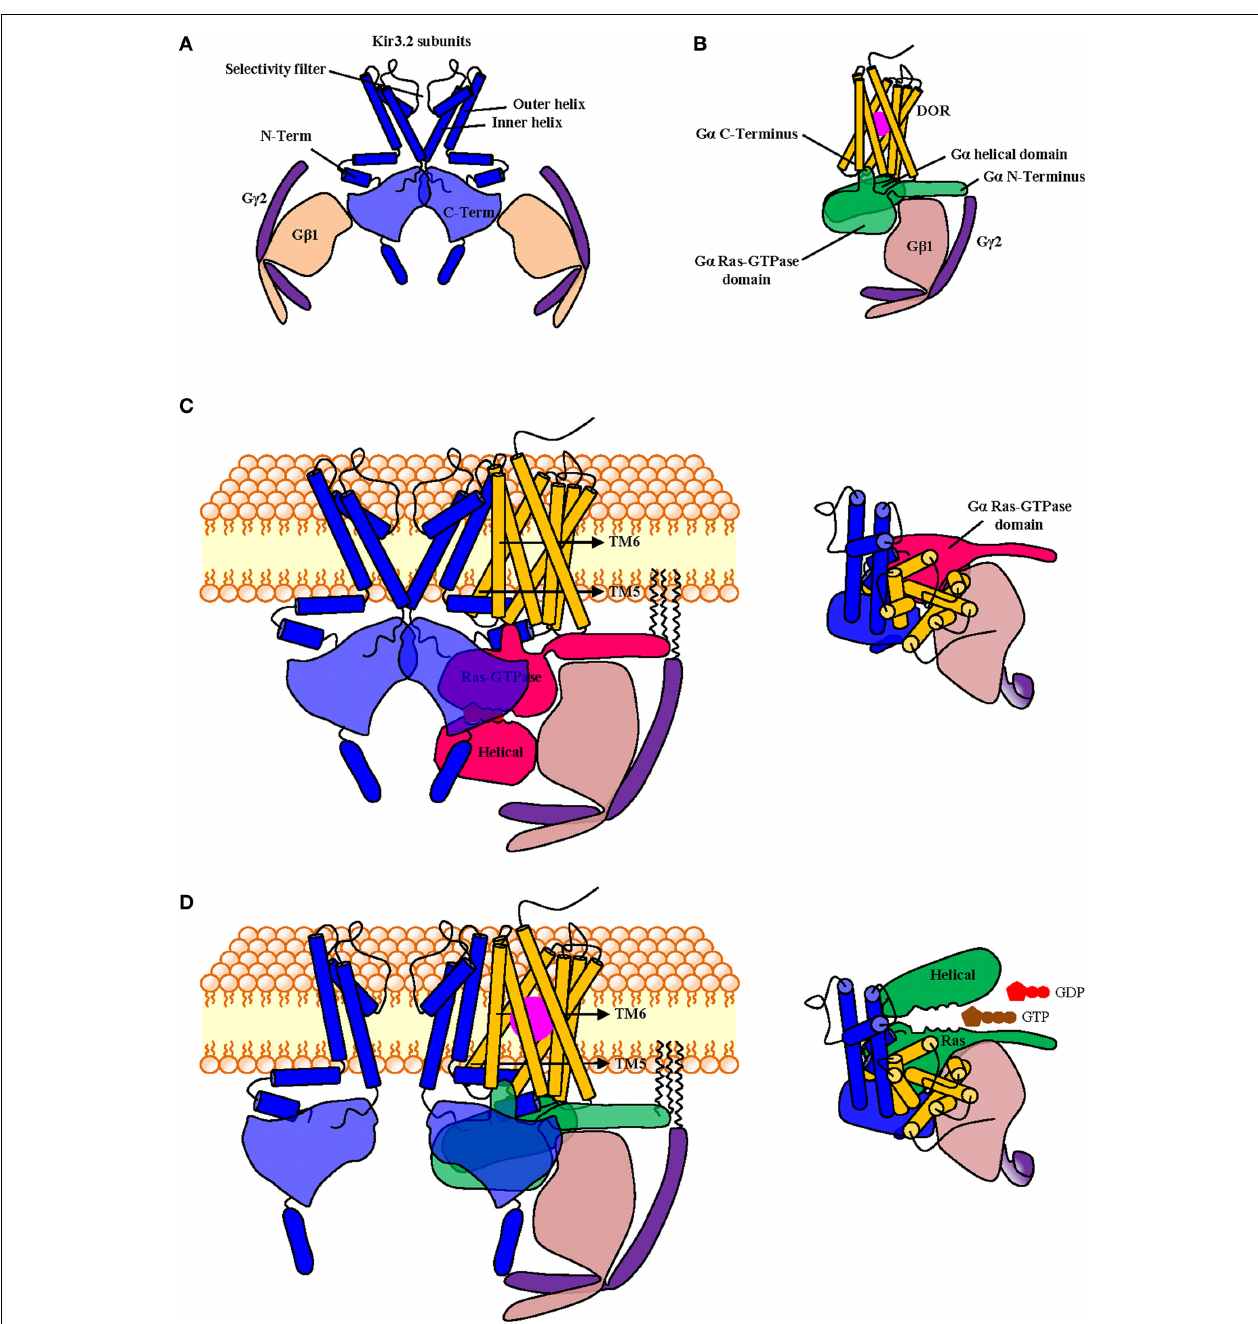
FIGURE 1 | Schematic representation of putative spatial organization of DORs, Kir3.2 and the G αβγ subunits within a signaling complex containing all signaling partners. The complex was constructed from diagrams based on the published crystal structures of the Kir3.2 tetramer in association with corresponding G β 1 γ 2 subunits (PDB: 4KFM) (A) and that of the nucleotide-free G α s β 1 γ 2 trimer in association with the active β 2 adrenergic receptor (PDB: 3sn6) where the latter was replaced by the topography corresponding to the DOR crystal (PDB: 4EJ4). Note that in the active receptor-G protein complex only the Ras-GTPase domain of G α is fully visible (B) . To construct the multimeric array, the DOR-G αβγ complex shown in B was associated to the Kir3.2 channel shown in (A) by superimposing both G βγ dimers and then removing the one corresponding to the channel. DOR and Kir3.2 subunits were both aligned with respect to the plain of the